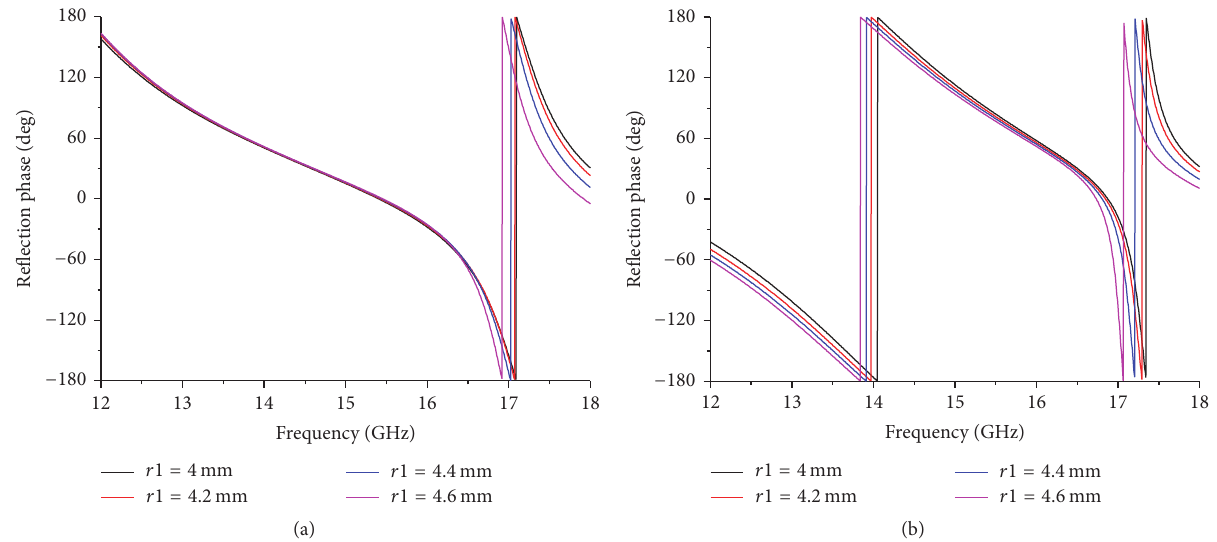
Figure 8: Reflection phase for various values of 𝑟1 : (a) under major axis polarized incidence; (b) under minor axis polarized incidence.